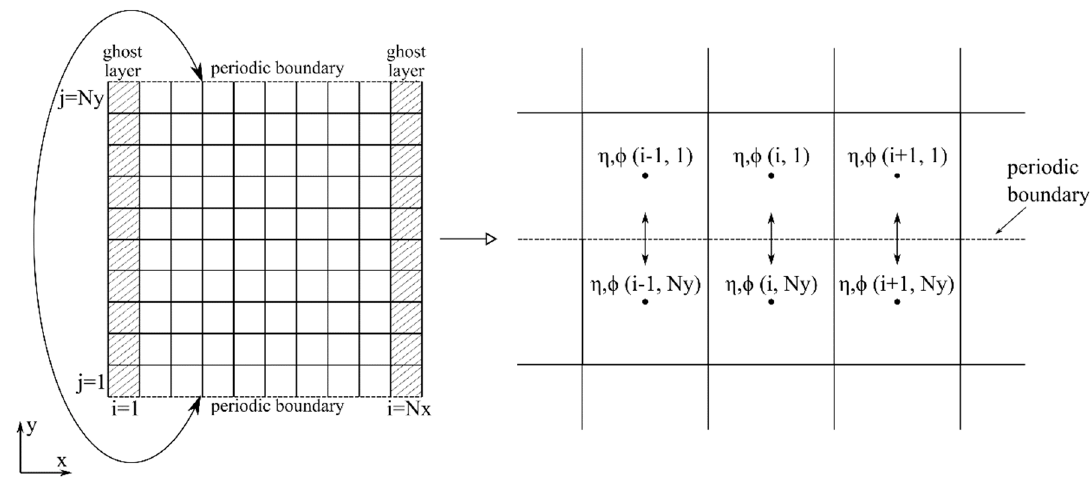
Figure 3. Definition sketch of the implemented periodic lateral boundaries.